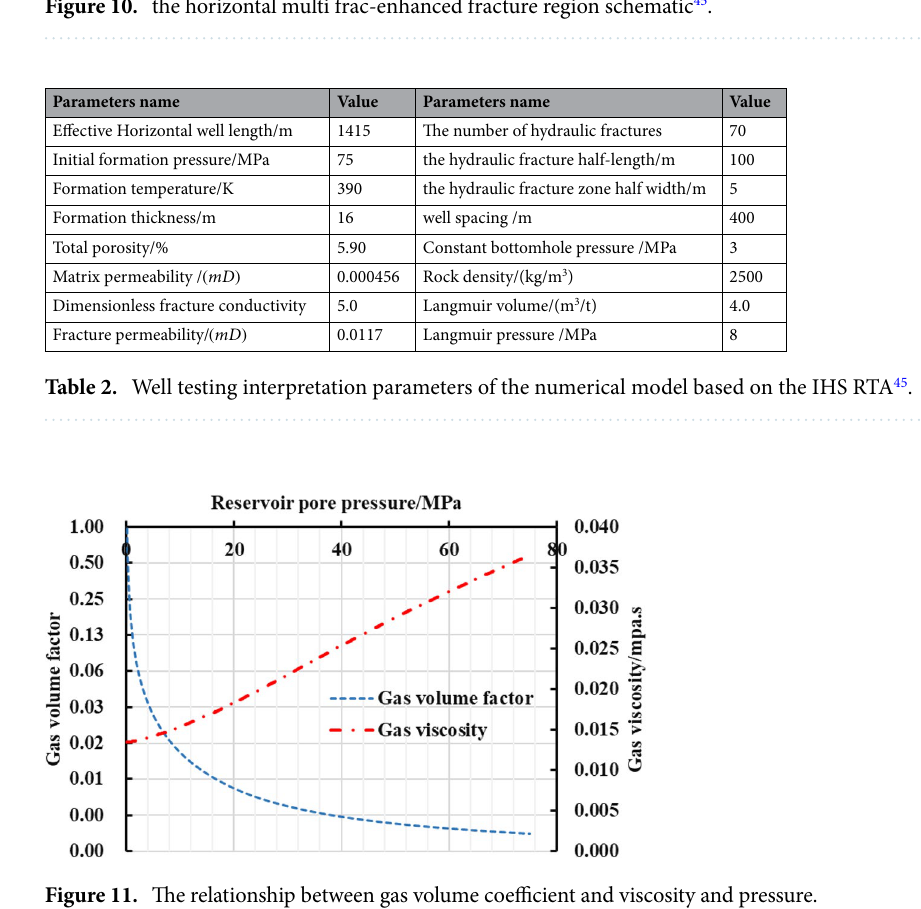
Figure 10. the horizontal multi frac-enhanced fracture region schematic 45 .